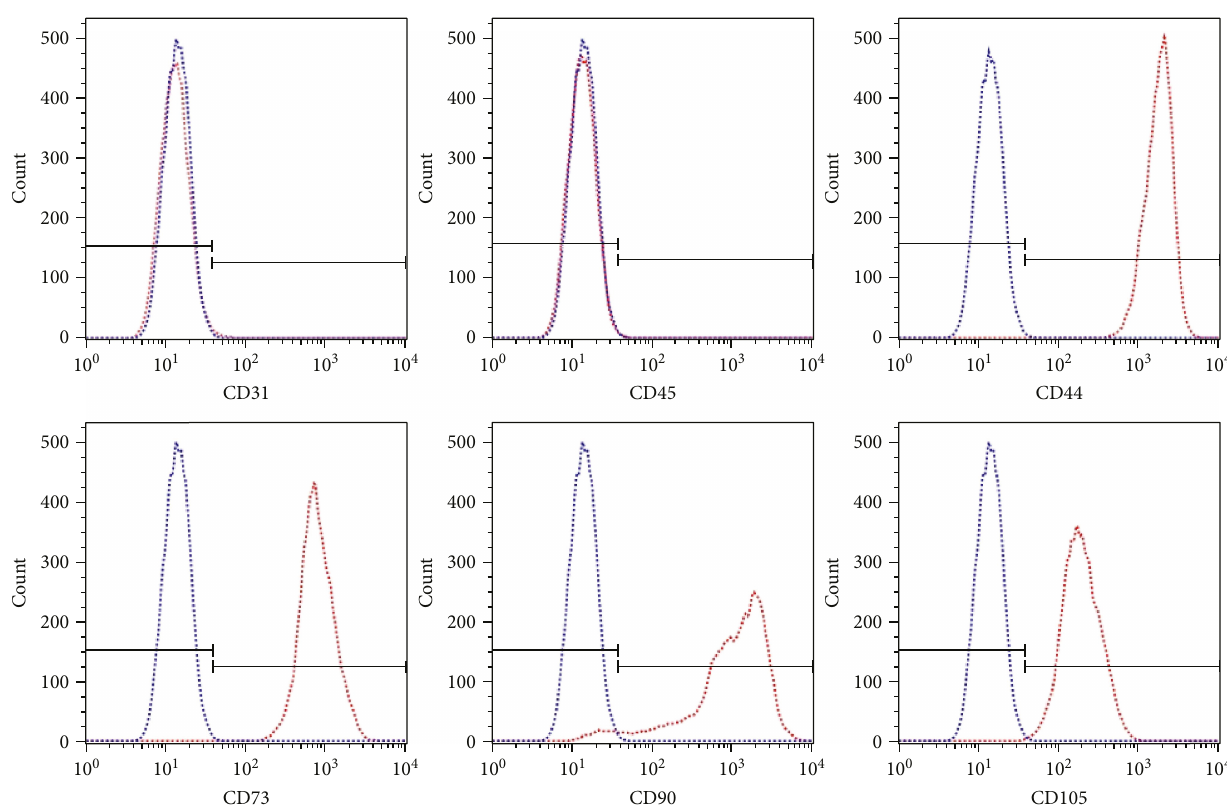
Figure 2: CD marker expression in hASCs was analyzed by fl ow cytometry. hASCs were negative ( < 2%) for CD31 and CD45 expression and positive ( > 90%) for CD44, CD73, CD90, and CD105 expression. The blue lines in each histogram indicate staining with the appropriate isotype control antibody. CD: cluster of di ff erentiation; hASCs: human adipose-derived stem